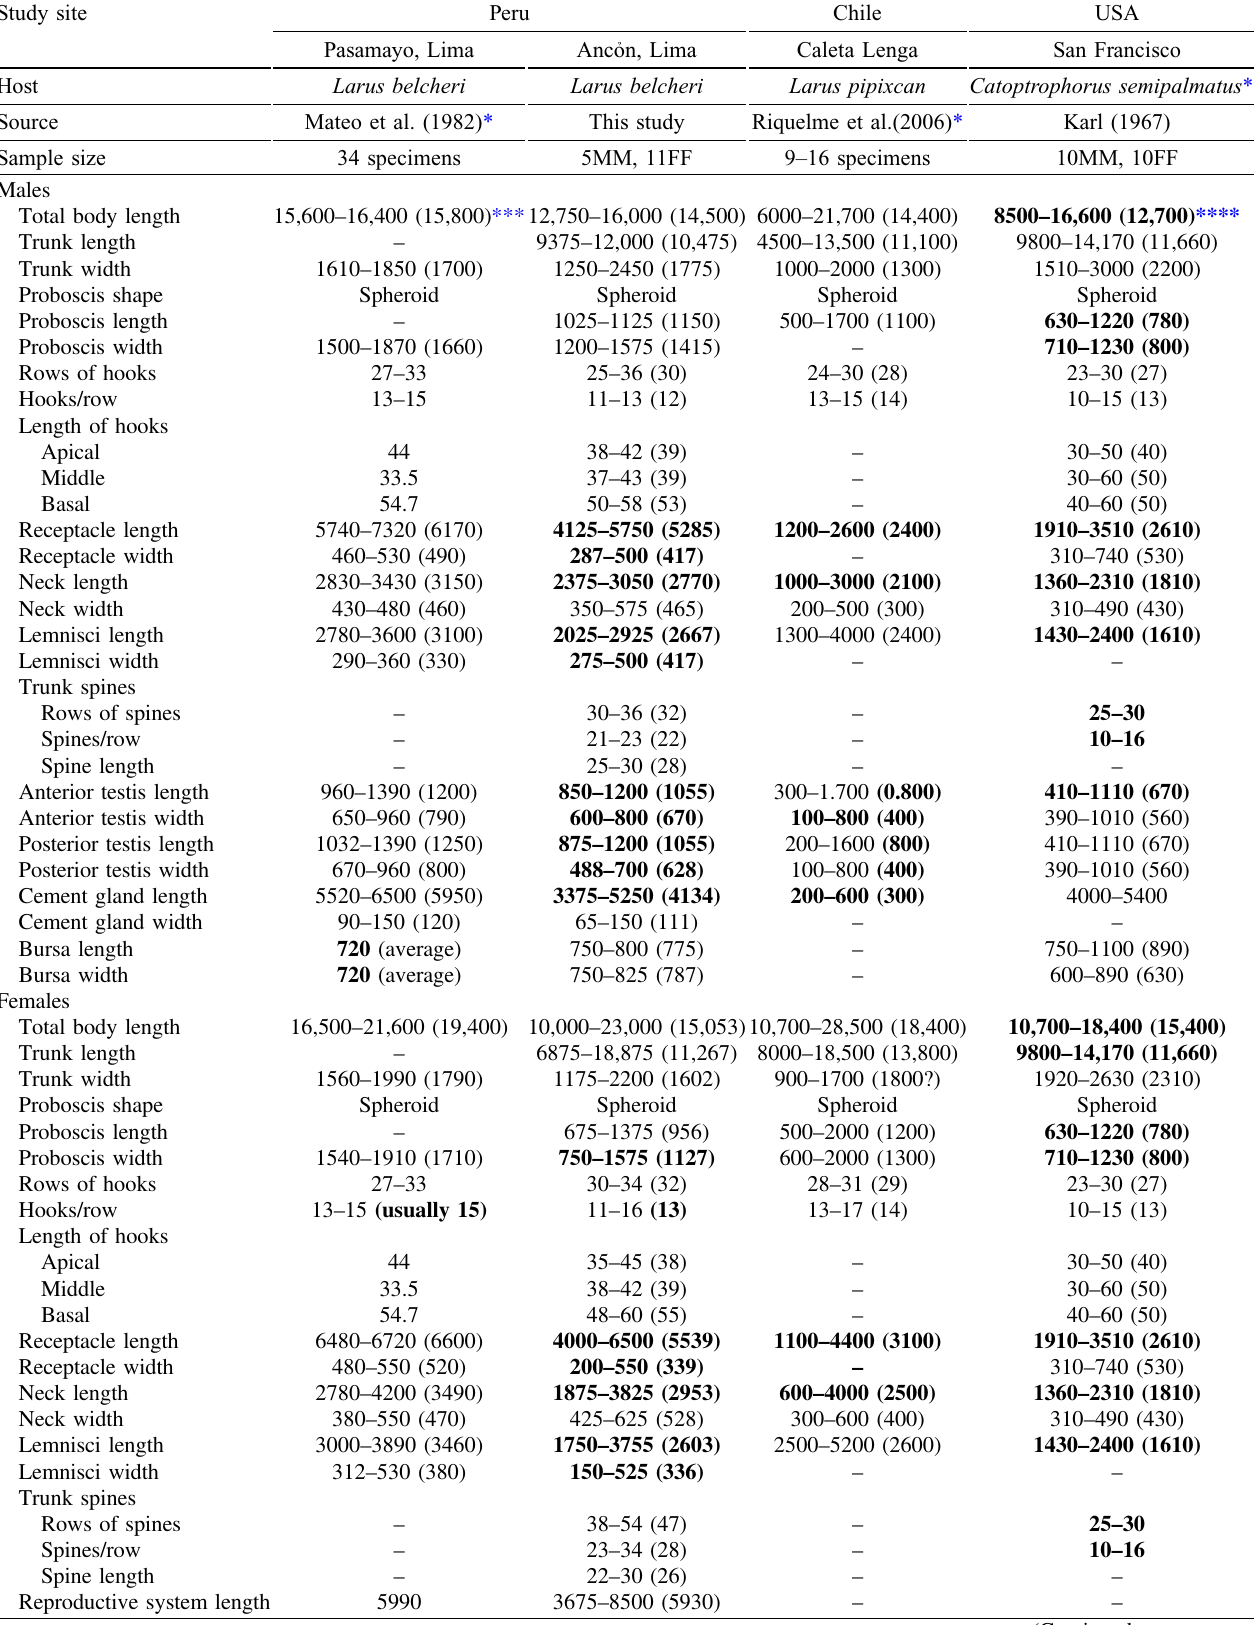
Table 3. Morphometrics of adults of Pro fi licollis altmani from Peru, Chile, the